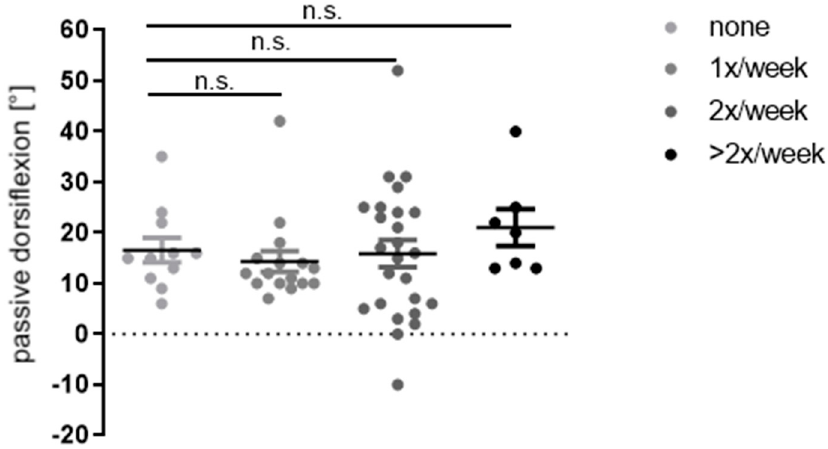
Figure 5. Influence of administration and frequency of physiotherapy on postoperative passive dor- siflexion .